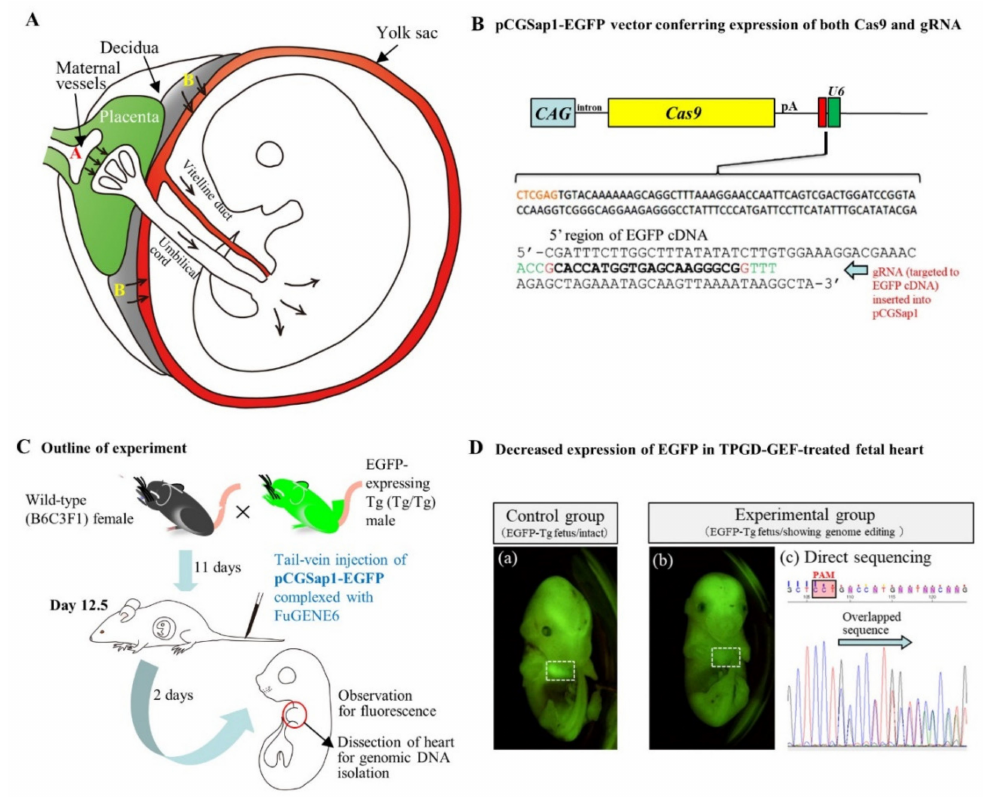
Figure 6. Transplacental gene delivery (TPGD) on day 12.5 (day 0 of pregnancy is defined as the day a vaginal plug is found): ( A ) Hypothetical mechanism of TPGD suggested by Kikuchi et al. [89] and Nakamura et al. [88]. When the TPGD is performed at day 12.5 (the time when placental circulation is established), the intravenously injected plasmid DNA / lipid complexes may be transferred via at least two routes from maternal blood to the fetus. One route is via placenta to the embryo, as indicated by the arrows (area A). Injected plasmid DNA is transferred beyond the blood-placenta barrier and enters the umbilical cord. The other route is from the decidua to the yolk sac, as depicted by the arrows (area B). Some DNA become trapped in the yolk sac and is transferred to the embryo via the vitelline circulation. ( B ) Structure of pCGSap1-EGFP, an all-in-one type plasmid, capable of expressing both Cas9 and gRNA (targeted to EGFP cDNA) simultaneously: This plasmid has been used for genome editing of EGFP-expressing fetal cardiac cells in TPGD-GEF (cited from Nakamura et al. [88] under permission of MDPI, publisher of the International Journal of Molecular Science ). ( C ) Schematic representation of the experimental outline of TPGD-GEF. At day 12.5 of pregnancy, a solution containing plasmid DNA complexed with gene delivery reagent (i.e., FuGENE6) was intravenously administered to the pregnant female mice. Two days after in vivo transfection, fetuses were dissected to check the presence of the introduced DNA and its expression. ( D ) Decreased expression of EGFP-derived fluorescence in the heart of a TPGD-GEF-treated fetus. ( a ) Intact control fetus. The heart (enclosed by white dashed box) exhibited strong fluorescence. ( b ) TPGD-GEF-treated fetus exhibiting reduced fluorescence in its heart (enclosed by white dashed box). ( c ) Sequence analysis of PCR products (corresponding to the 5 (cid:48) region of the EGFP sequence) from the fetus ( b ). Overlapping electrophoretograms (indicated by arrows) immediately upstream of the protospacer adjacent motif (PAM) indicate mosaic pattern of